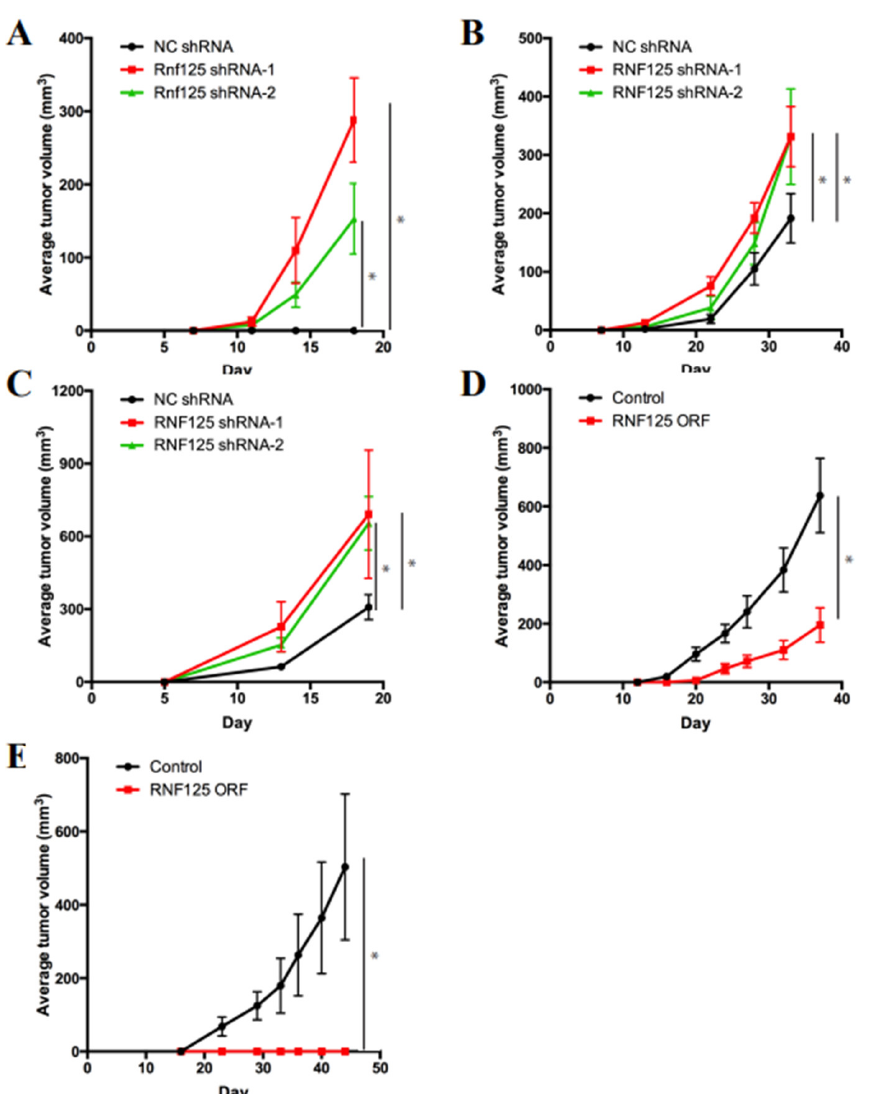
Figure 2. RNF125 inhibits HCC tumor development. ( A ) Knockdown of RNF125 in mouse immortal- ized liver progenitor cells (LPCs) led to accelerated xenograft tumor growth in athymic nude mice (* p < 0.05). ( B ) Knockdown of RNF125 in HepG2 HCC cells led to accelerated xenograft tumor growth in athymic nude mice (* p < 0.05). ( C ) Knockdown of RNF125 in SNU-398 HCC cells led to accelerated xenograft tumor growth in athymic nude mice (* p < 0.05). ( D ) Overexpression of RNF125 in PLC/PRF/5 HCC cells led to decelerated xenograft tumor growth in athymic nude mice (* p < 0.05). ( E ) Overexpression of RNF125 in HepB3 HCC cells led to decelerated xenograft tumor growth in athymic nude mice (* p < 0.05).